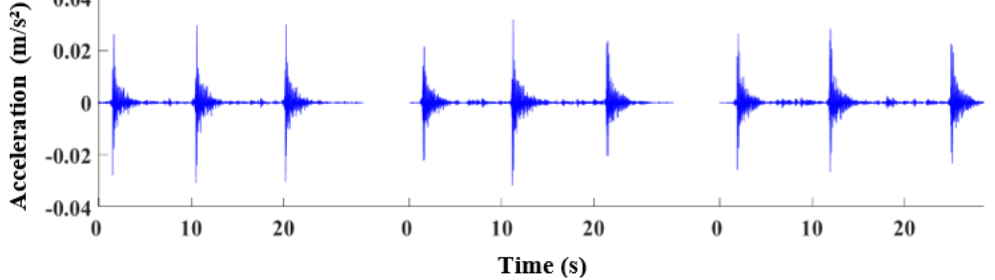
Figure 7. Acceleration x time recorded by channel 2, located at floor 1